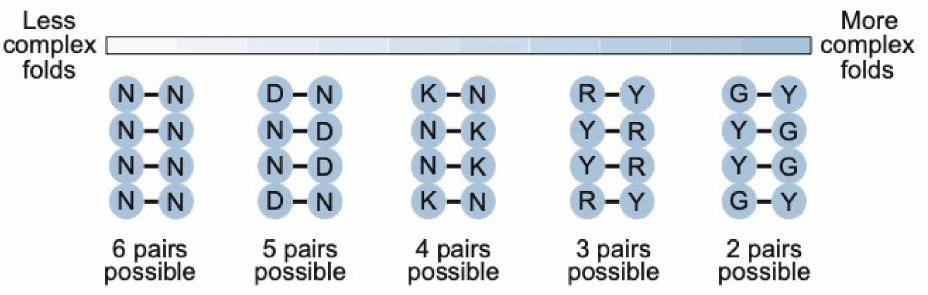
Figure 8. Relationship between the complexity of the secondary structure and the optimal coding scheme for base pairs in secondary structure libraries. Y = C or U (T); R = A or G; K = G or U (T); D = A, G, or U (T); N = A, C, G, or U